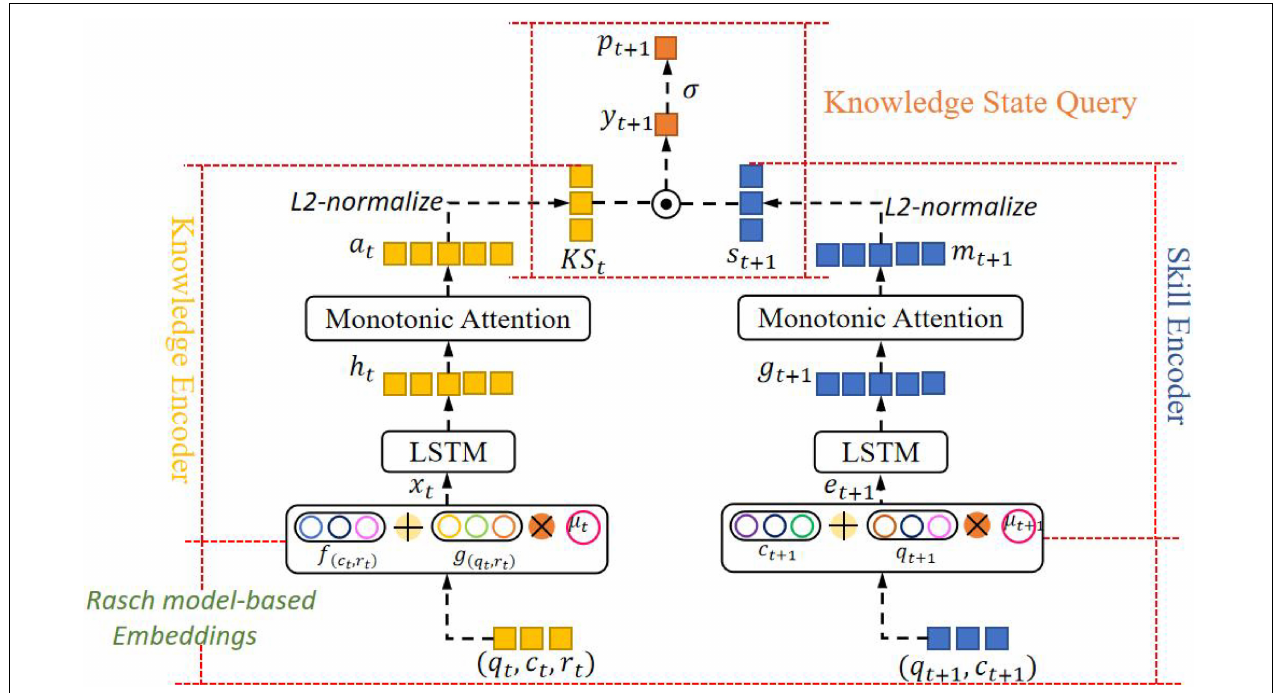
FIGURE 2 | The overall framework of the CAKQN